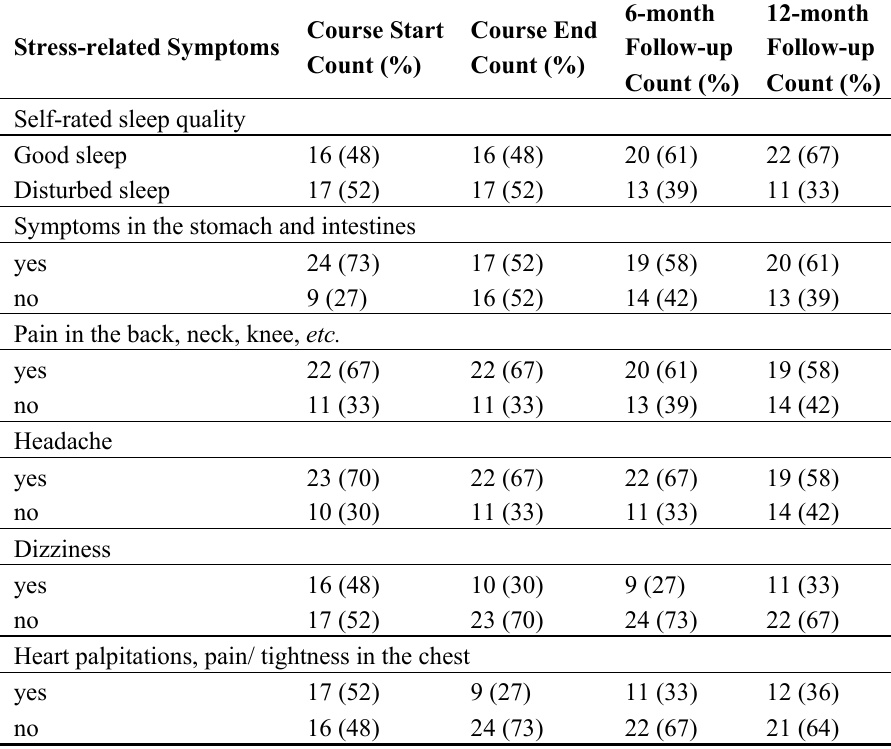
Table 5. Stress-related symptoms (count and percentage) reported by participants at course start, course end and 6- and 12-month